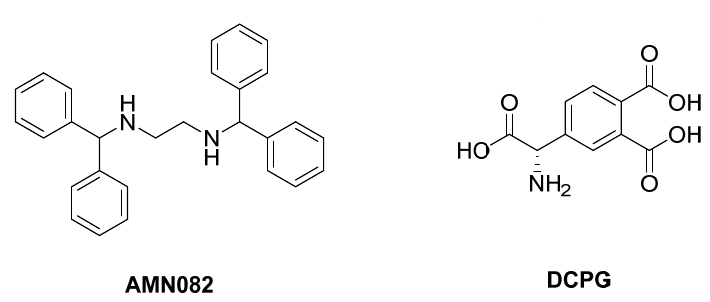
Figure 9. mGlu7R and mGlu8R ligands.